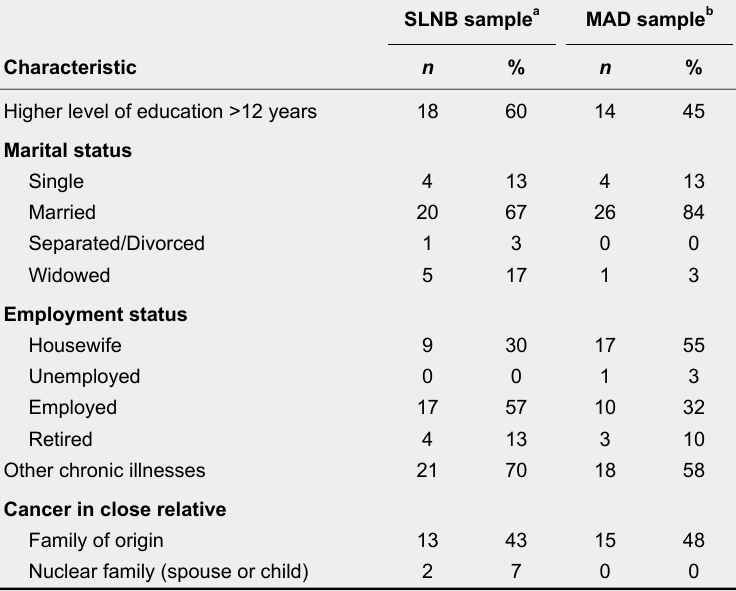
Demographics and Medical Characteristics of